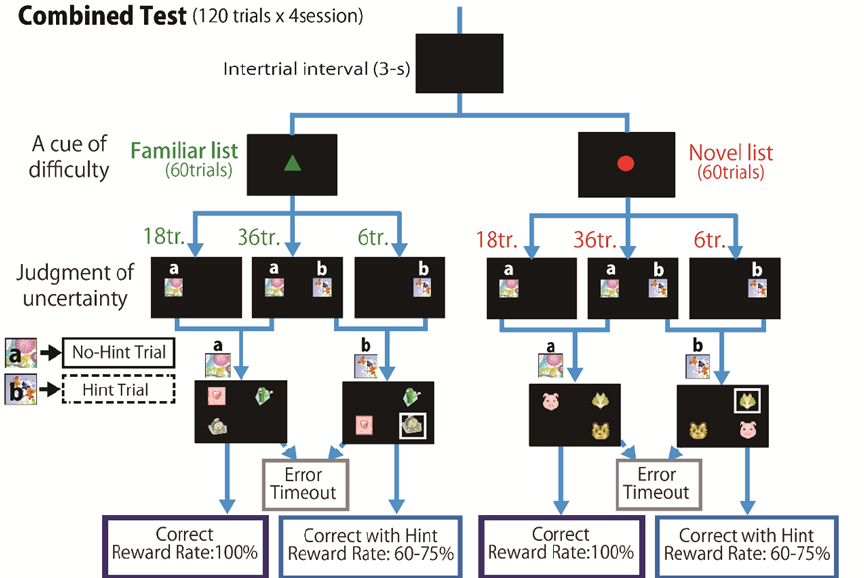
Figure 2 . A schematic representation of Iwasaki et al. (2018). In this test, pigeons were presented with a trial that combined rules of two training phases. After ITI, either the green triangle or the red circle appeared as a self-start key. Before proceeding to each associated list, the hint-available icon, the hint-unavailable icon, or both icons were presented. Subjects were able to obtain a hint by responding to the hint-available icon. All correct responses without hints were reinforced by food, but only 60% or 75% of correct responses on hint trials were reinforced. Incorrect responses resulted in a timeout irrespective of whether a hint was used. If pigeons were able to judge their uncertainty, they should choose the hint-available icon before solving a task with the novel list. From Iwasaki, S., et al. (2018). Pigeons ( Columba livia ) know when they will need hints: Prospective metacognition